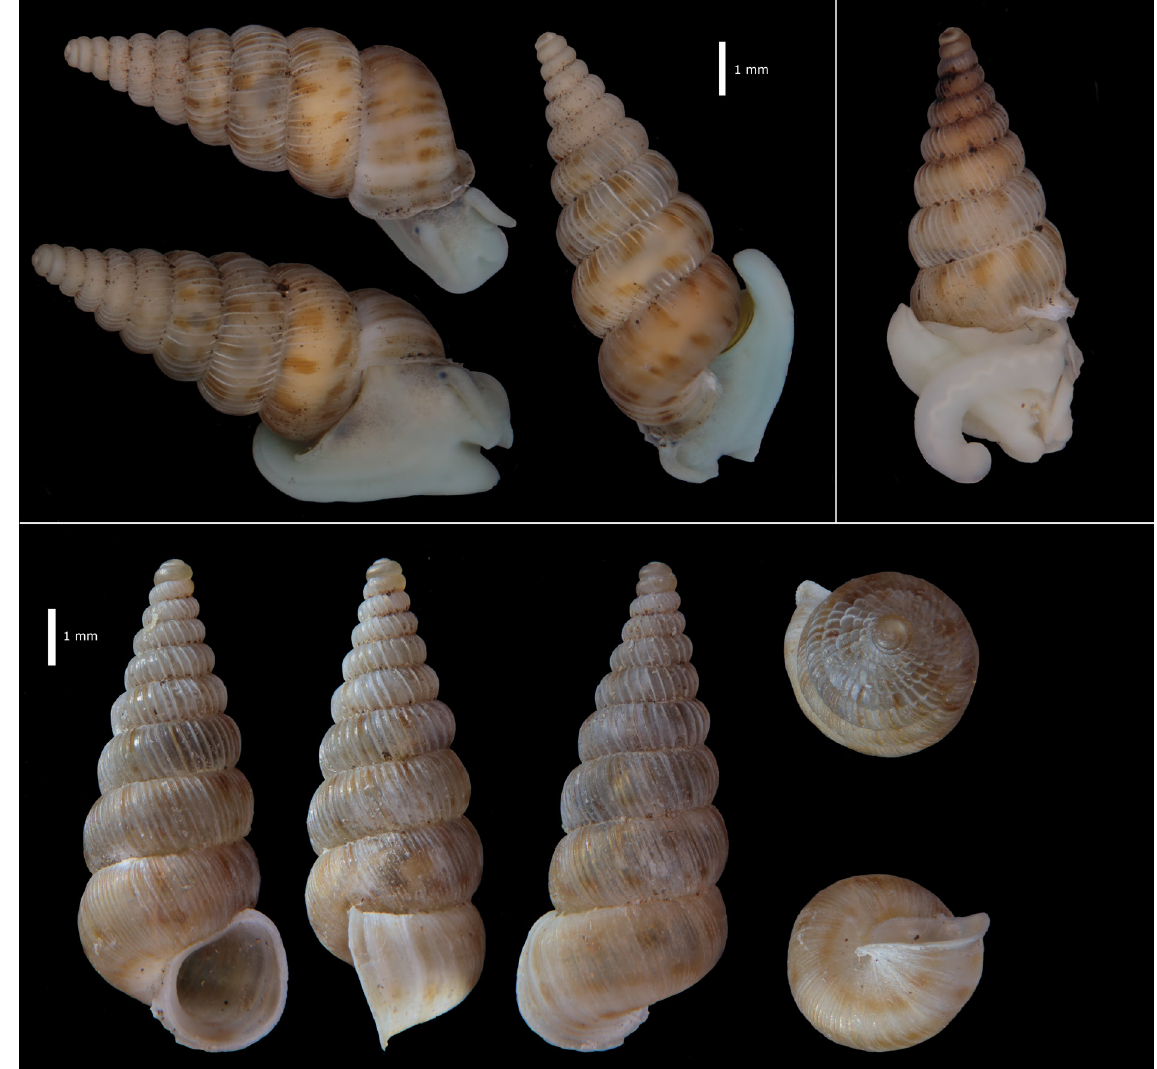
Fig. 27. Cochlostoma ( Clessiniella ) stelucarum sp. nov. Top left: holotype, ♀ (RMNH.MOL.347617), H = 8 mm. Top right: paratype, ♂ (RMNH.MOL.347618), H = 7 mm. Bottom: paratype, ♀ (RMNH. MOL.347619), empty shell, H = 8.7